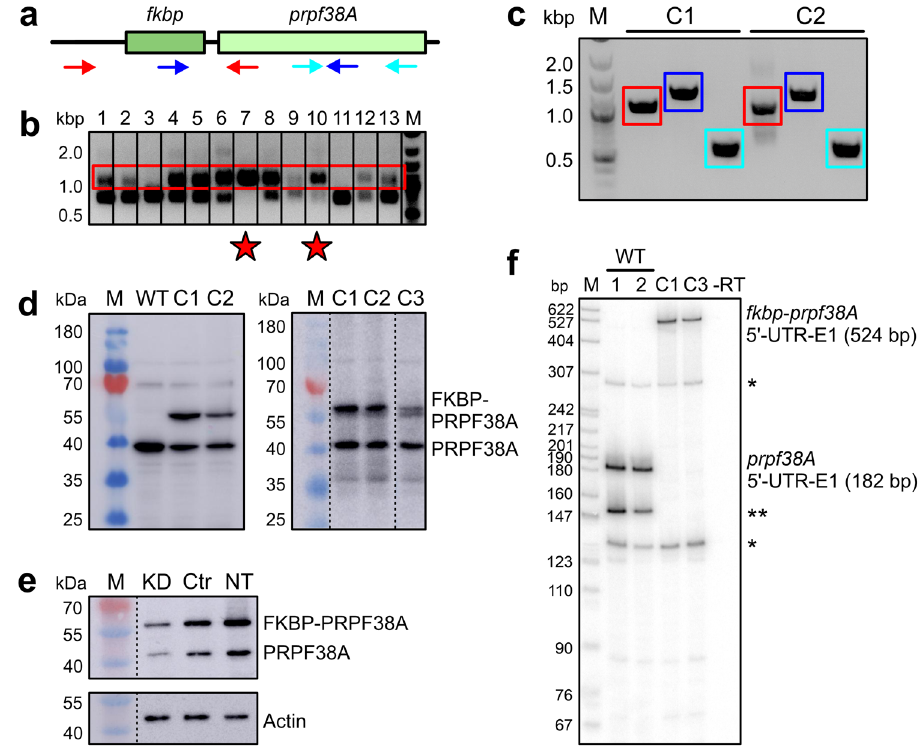
Fig. 4 CRISPR/Cas9 integration of an FKBP-coding region into the prpf38A locus. a Scheme depicting primer pairs (arrows; Supplementary Table S1) used in experiments shown in b , c . b CRISPR/Cas9-mediated integration of an FKBP-coding region upstream of the PRPF38A-coding region on the endogenous prpf38A locus. Engineered clones (a subset of 50 clones shown in lanes 1 – 13) were tested by PCR with the red primer pair in a . Ampli fi ed bands originating from successful fkpb insertion are boxed in the same color as the respective primer pair in a . Heterozygously edited clones show two bands, homozygously edited clones exhibit a single upper band. Star symbols, homozygously edited clones. M, size marker (kbp). c Homozygous fkbp integration in clones C1 and C2 was further validated by PCR analyses and sequencing of the ampli fi ed products. Ampli fi ed bands are boxed in the same color as the respective primer pairs in a . d Left panel, Western blot analysis with an anti-PRPF38A antibody of cell cultures from WT and the two homozygously edited clones C1 and C2. Right panel, Western blot analysis with an anti-PRPF38A antibody of the CRISPR cell lines C1 and C2 in comparison to the cell line C3, in which the authentic start-ATG (methionine) of the prpf38A -coding region was additionally converted to a CTG (leucine) codon by CRISPR/Cas9-based engineering. The lanes of the right panel originated from the same gel but were rearranged for display purposes as indicated by dashed lines. e Western blot analysis with an anti-PRPF38A antibody after siRNA-mediated knockdown of FKBP-PRPF38A in doubly engineered FKBP- PRPF38A CRISPR/lamin A-ECFP-SNAP stable cell line. Cells were analyzed two days after treatment with prpf38A siRNA (KD), control siRNA (Ctr), or no treatment (NT). Bottom panel, staining of the stripped membrane with an anti-actin antibody as a loading control. f Radioactive PCR with a forward